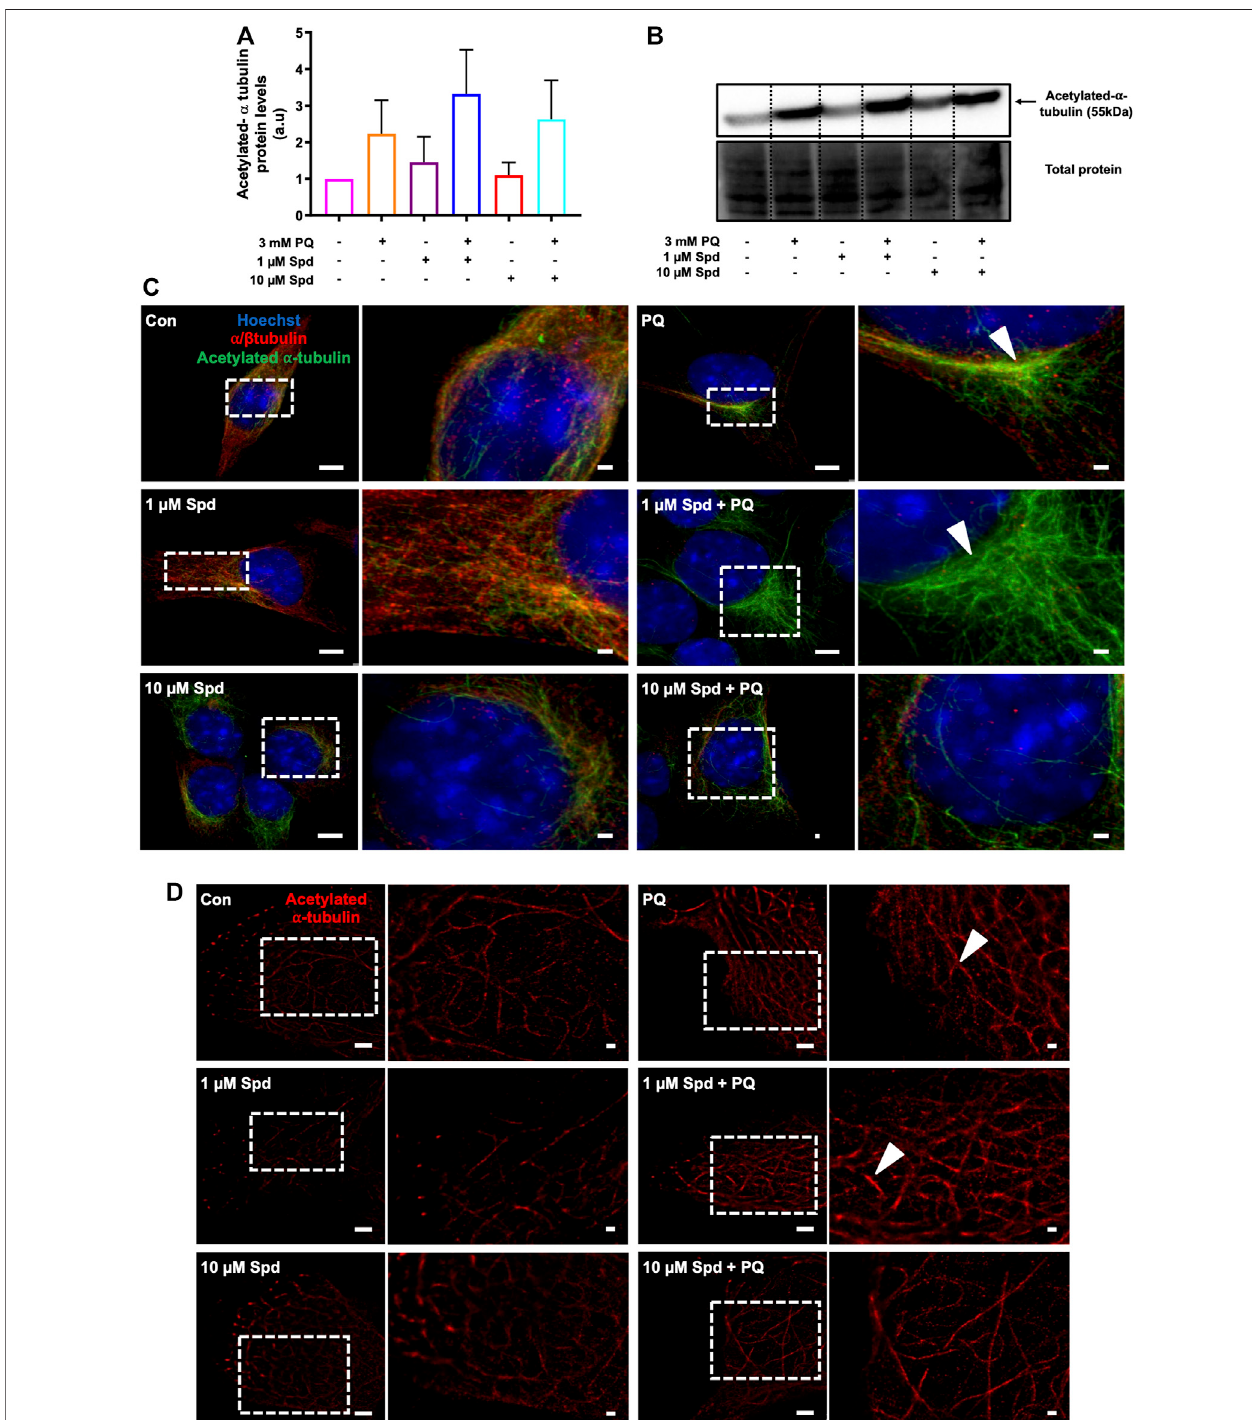
FIGURE 8 | Spermidine increases the acetylation signal of tubulin in paraquat treated cells. (A) densitometric quanti fi cation and (B) representative western blot for acetylated α -tubulin protein levels in GT1-7 cells following treatment with a low and high concentration of spermidine followed by exposure to paraquat. Data are presentedasmean±SEM, n =3. (C,D) representativemicrographsforacetylated α -tubulin withSR-SIM (scalebar:5and1 μ m)anddSTORM(scalebar:2and0.5 μ m) showing highest intensity signal with 1 μ M Spd + PQ compared to PQ. Arrowheads indicate regions of strong acetylated α -tubulin signal.